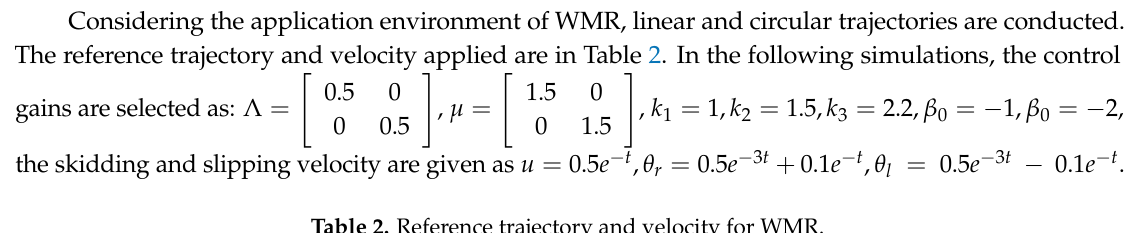
Table 2. Reference trajectory and velocity for